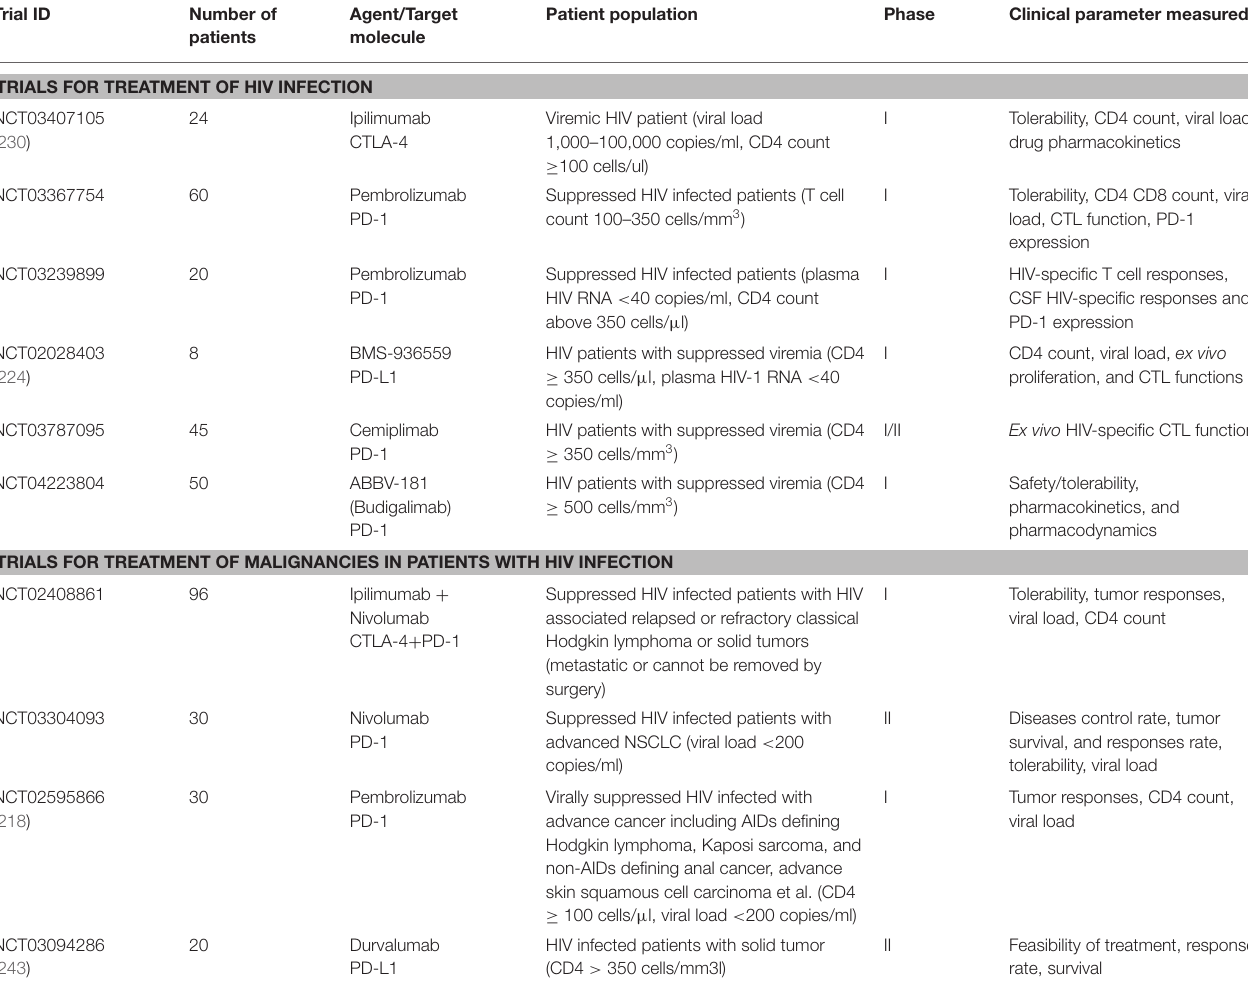
TABLE 2 | Clinical trials of immune checkpoint blockade in HIV infected patients. Trial